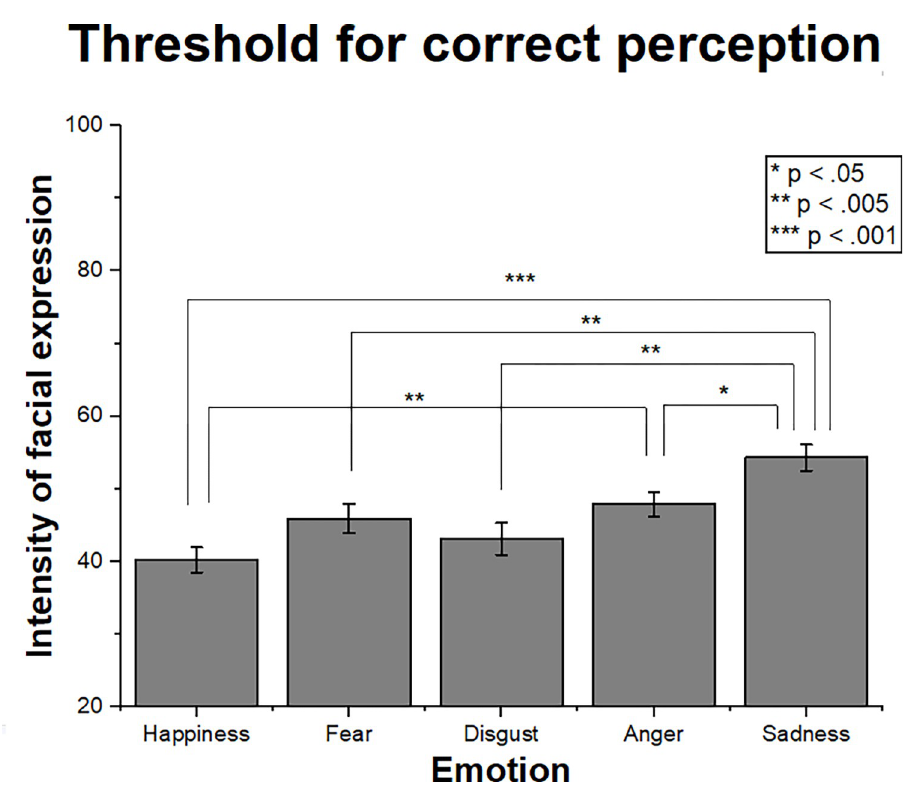
Fig 3. Perception thresholds of each emotion category. Mean intensities and standard errors for correct identification of each emotion for all odor conditions grouped. Sadness presented the highest perception threshold between the emotions, and fear was significantly higher than happiness. The significant differences are illustrated by asterisk